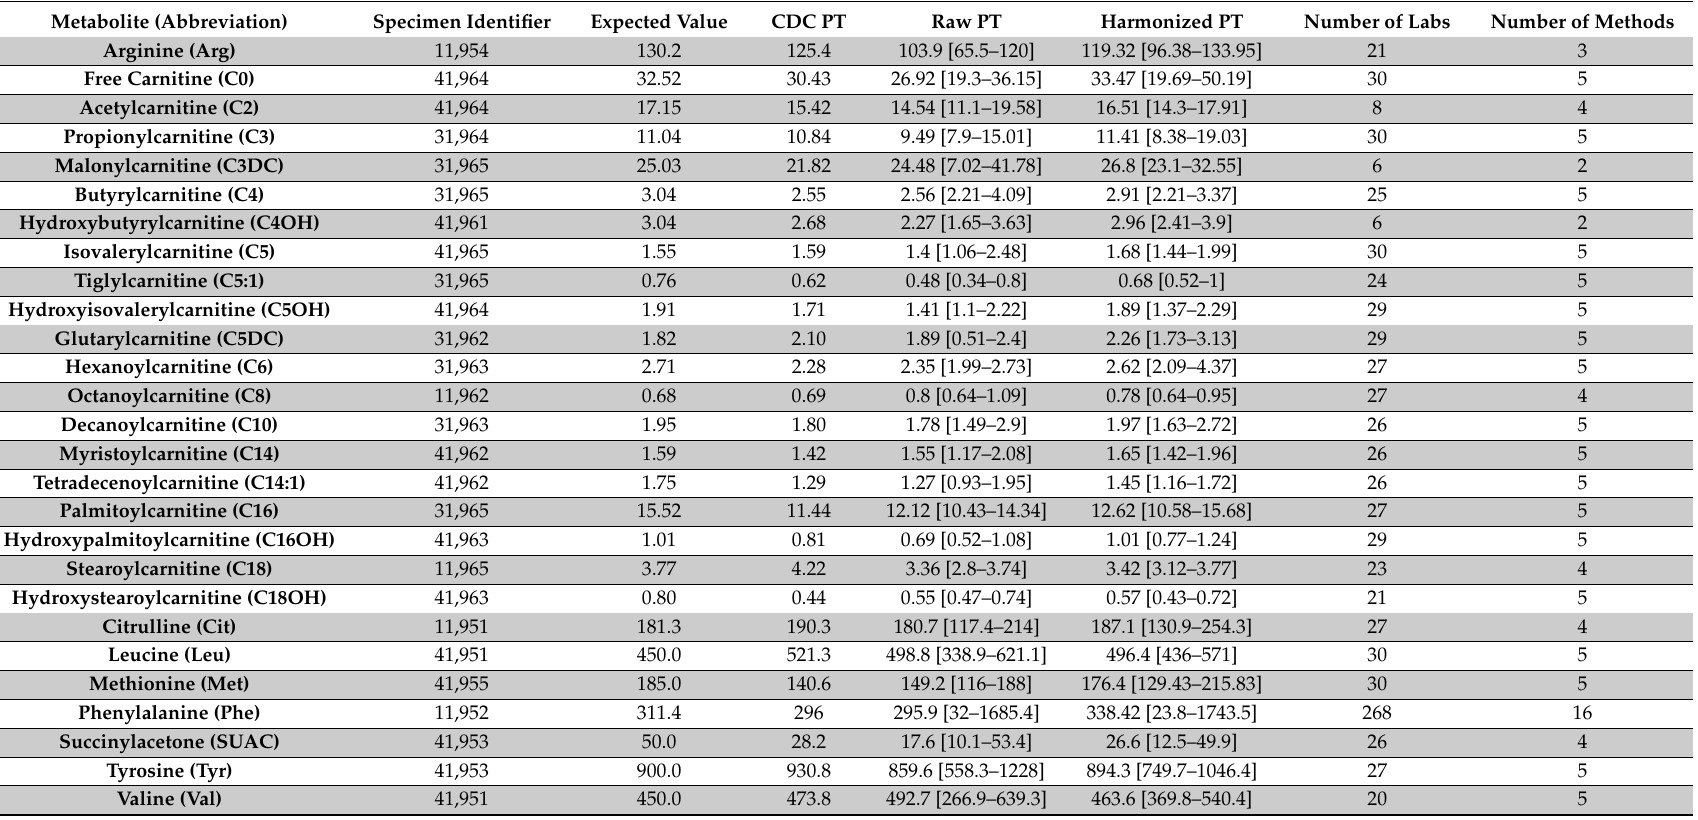
Table 1. Metabolite descriptive information and results from proficiency test specimens distributed in